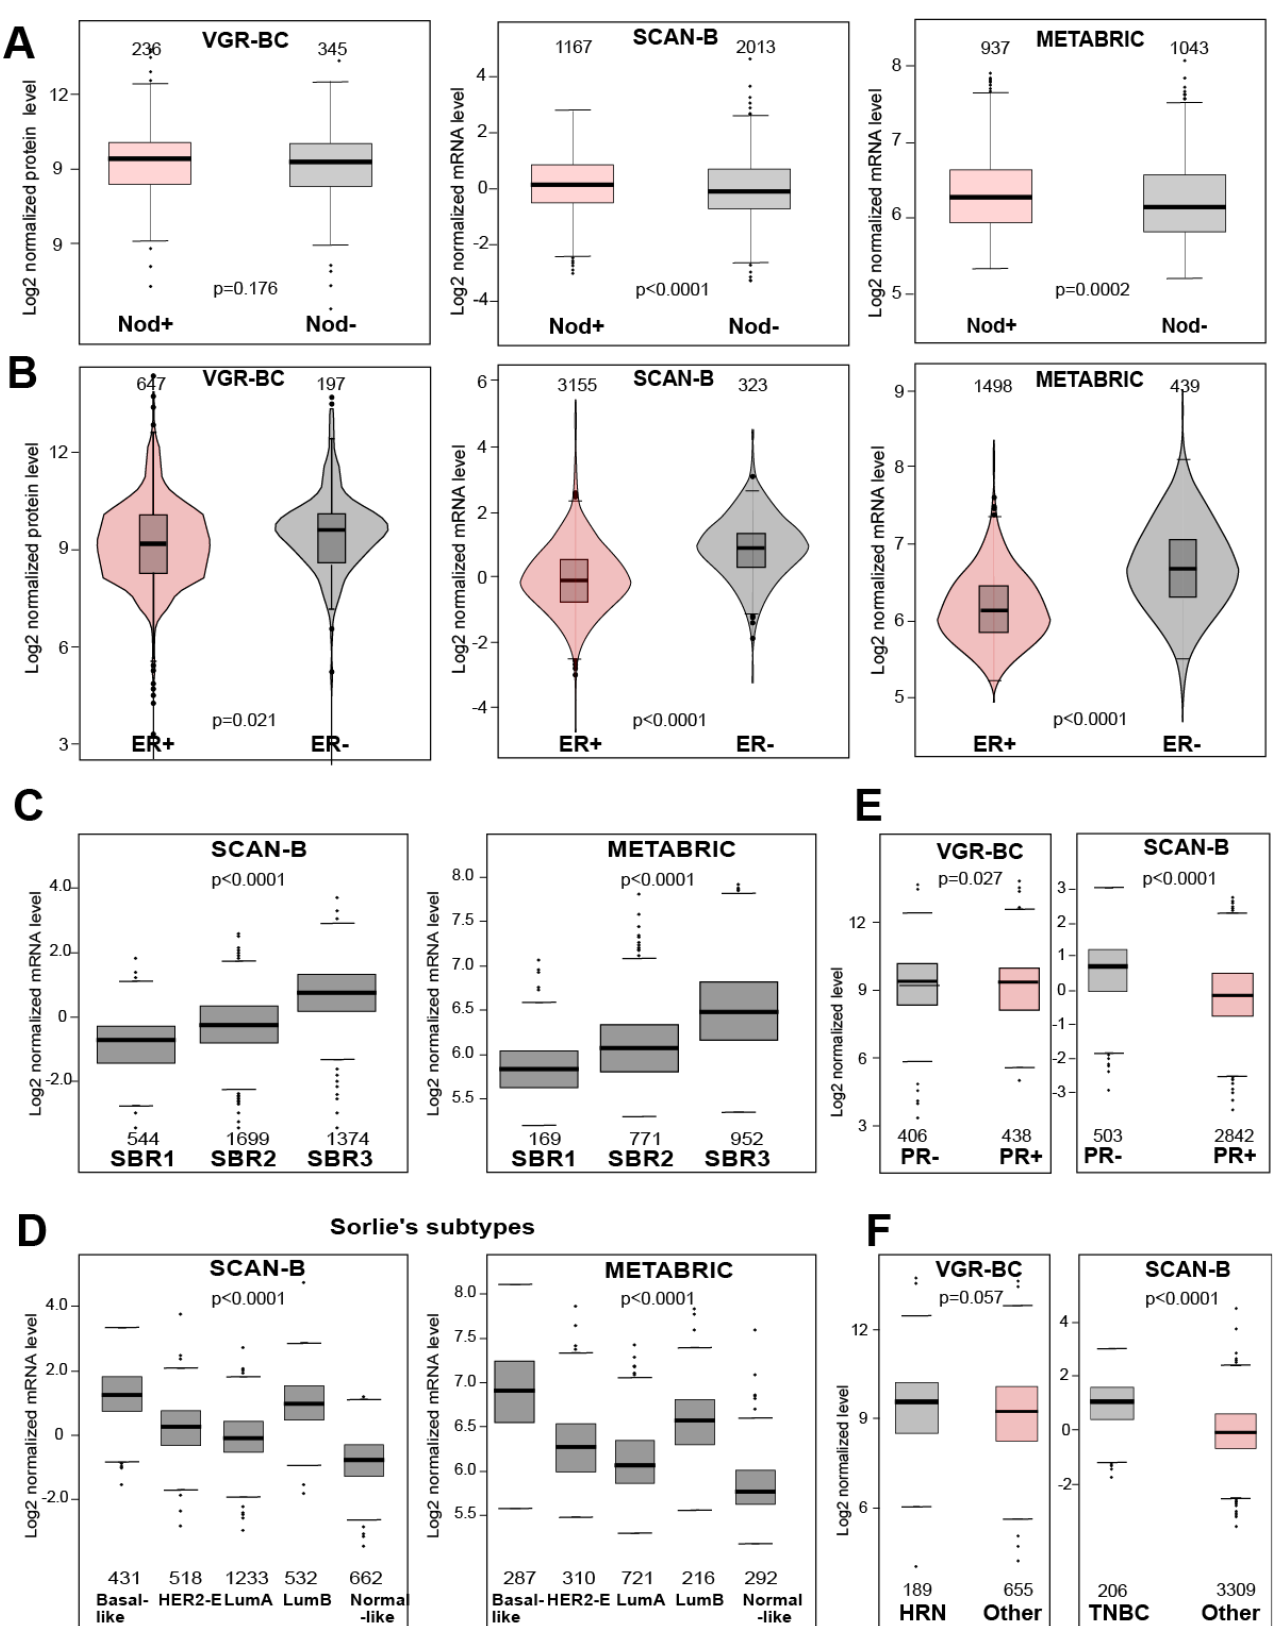
Figure 3. BIRC5/survivin level variation across BC subtypes and clinical characteristics. ( A ) Boxplots show log2 normalized BIRC5/survivin levels in nodal-positive and nodal-negative tumors. p -values are obtained by the Welch and